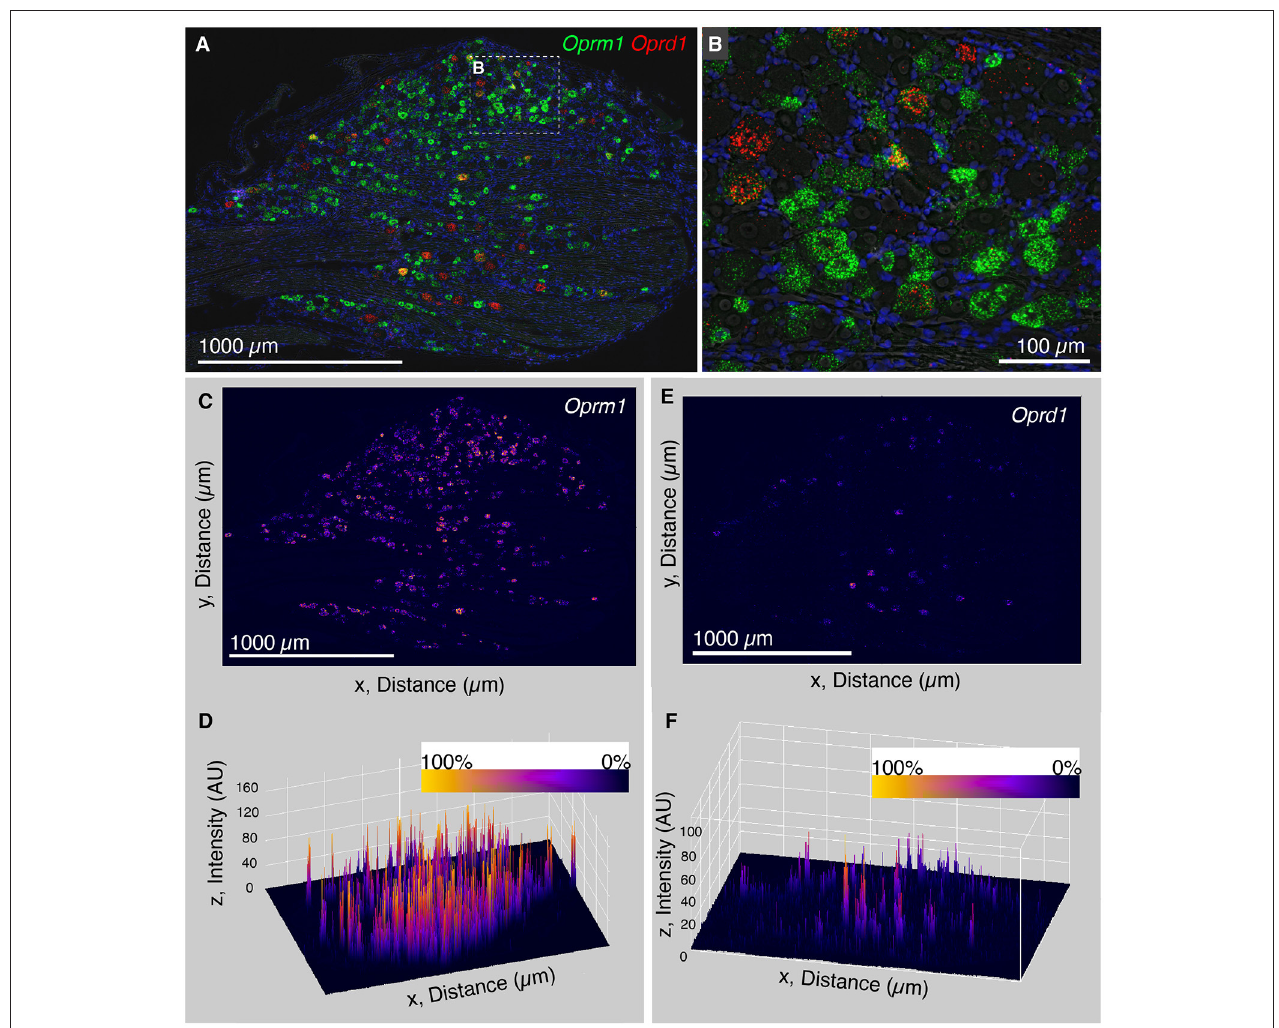
FIGURE 3 | Analysis of intensity distribution for the opioid receptor genes Oprm1 and Oprd1 . The finding that Trpv1 was unevenly distributed in rat DRG prompted an investigation of Oprm1 and Oprd1 to answer whether these analgesic opioid receptors were also distributed unevenly across cell populations. (A) In a wide field view of a DRG stained for Oprm1 and Oprd1 , we did not observe marked differences in expression across the field. The gene encoding the mu-opioid receptor ( Oprm1 ) is much more widely expressed than the delta receptor gene ( Opd1 ), and both show a range of expression values. (B) However, this range appeared qualitative smaller than that observed for Trpv1 . (C) In order to quantify this further, we used a surface plot to represent intensity over area for Oprm1 . (D) When viewed from an angle, this analysis shows many peaks of similar height across the DRG, consistent with the wide expression pattern of Oprm1 . This is in contrast to Trpv1 , which showed several very high peaks ( Figure 2E ). (E) The same analysis was also performed for Oprd1 , which is expressed in many fewer cells than either Trpv1 or Oprm1 . (F) Viewed at an angle, most of these Oprd1 peaks are evident in the same linear axis. In Supplementary Figure 2 , we quantified differences in distribution and coefficient of variation in these measurements, showing that Trpv1 had significantly higher coefficient of variation than either Oprm1 or Oprd1